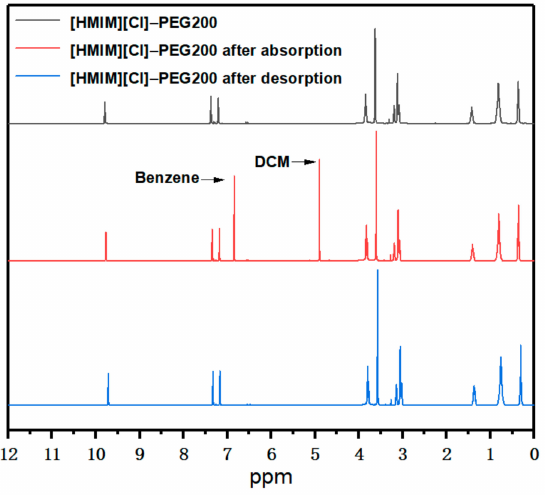
Figure 8. The 1 H-NMR spectra of [HMIM][Cl]–PEG200, [HMIM][Cl]–PEG200 after absorption, and [HMIM][Cl]–PEG200 after